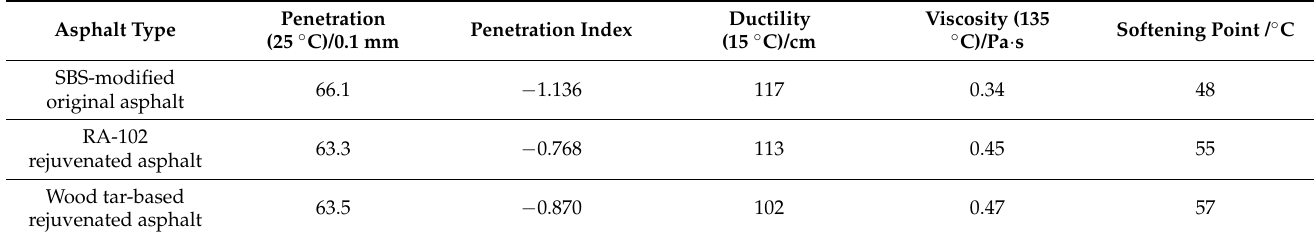
Table 1. Basic properties of each asphalt [13].